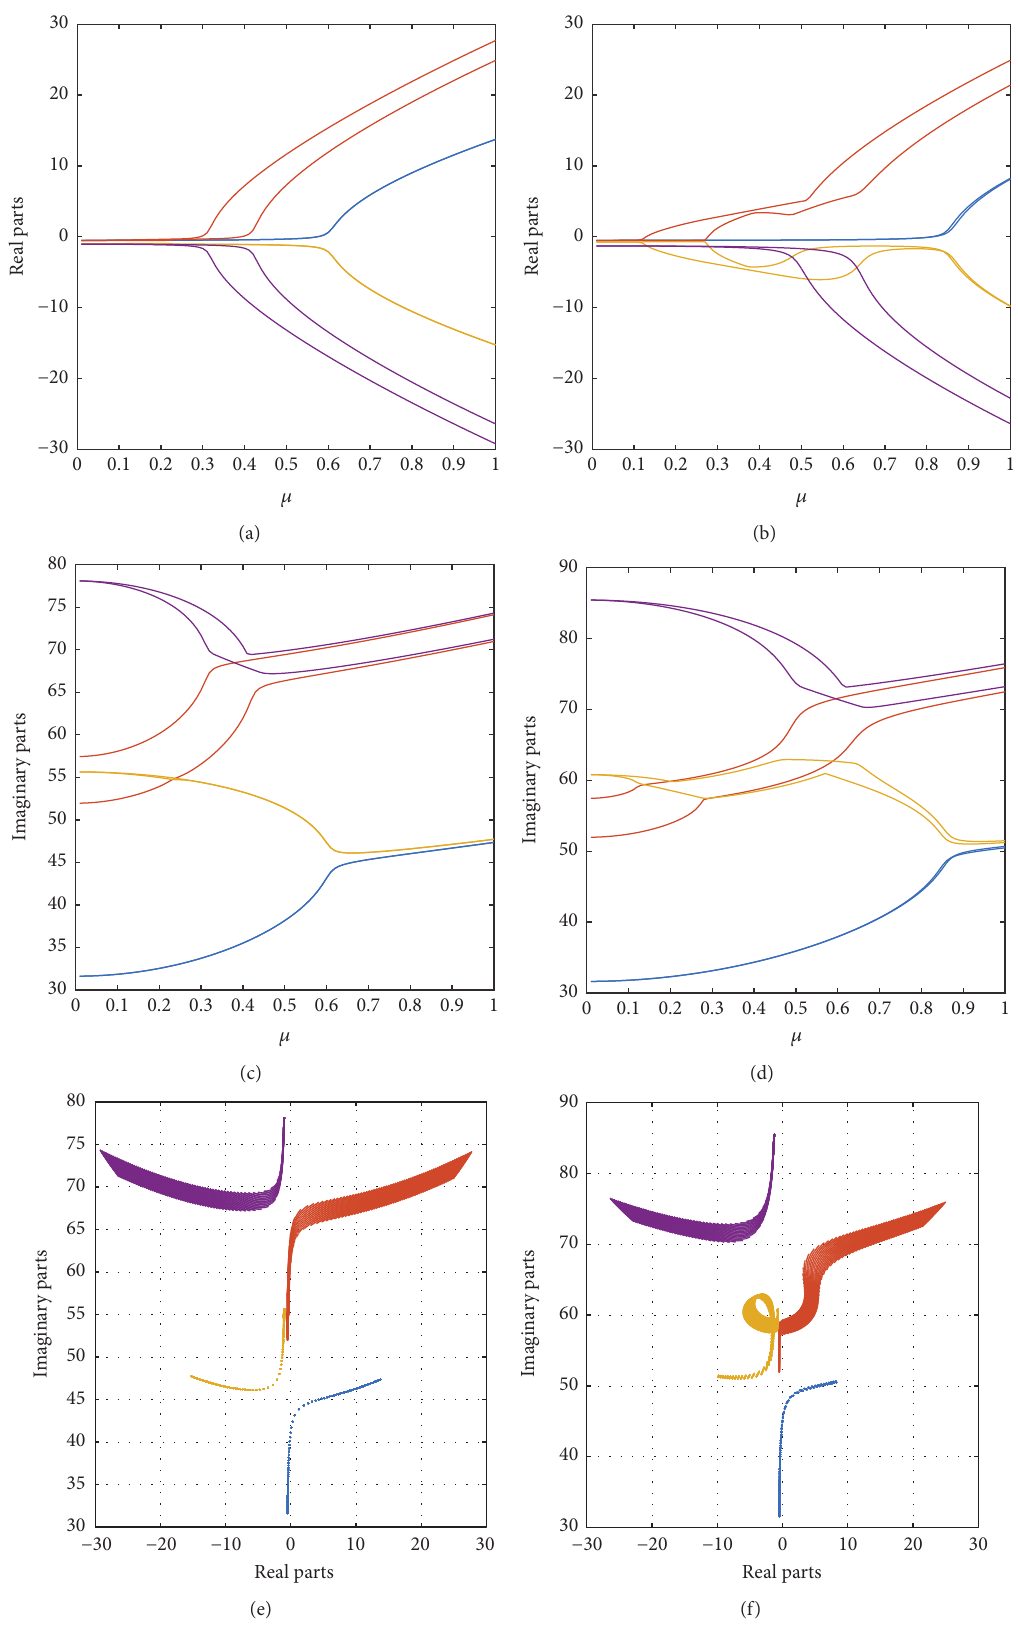
Figure 3: Two-dimensional parameter space: real (a, b) and imaginary (c, d) parts of eigenvalues versus 𝜇 and evolution in the complex plan (e, f) for configurations 1 (a, c, e) and 2 (b, d,